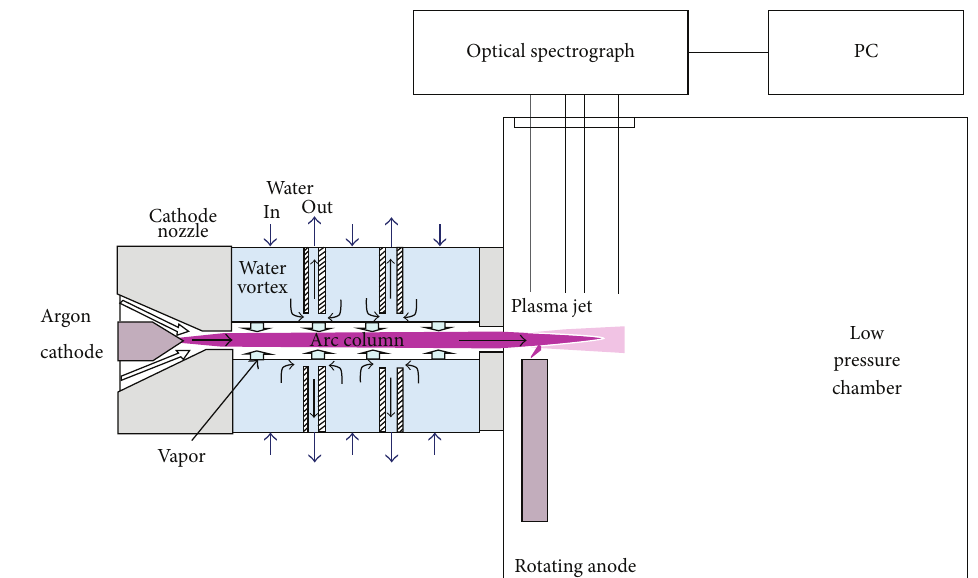
Figure 1: Schematic view of the plasma torch attached to the low pressure chamber and plasma jet observed by the